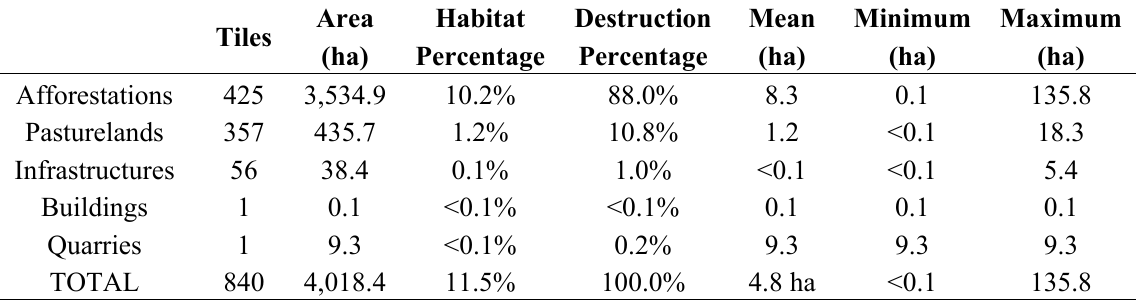
Table 2. Stats of causes of dry heaths destruction in the SCI Os Ancares–O Courel during the period